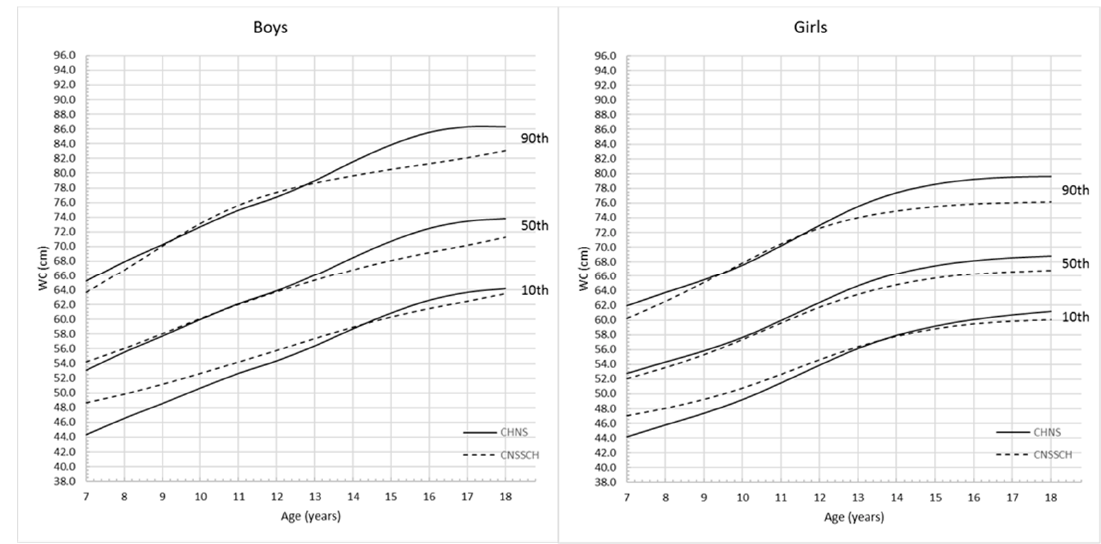
Figure 5. Comparison of the CHNS and CNSSCH WC percentile curves for Chinese boys and girls aged 7–18 years.